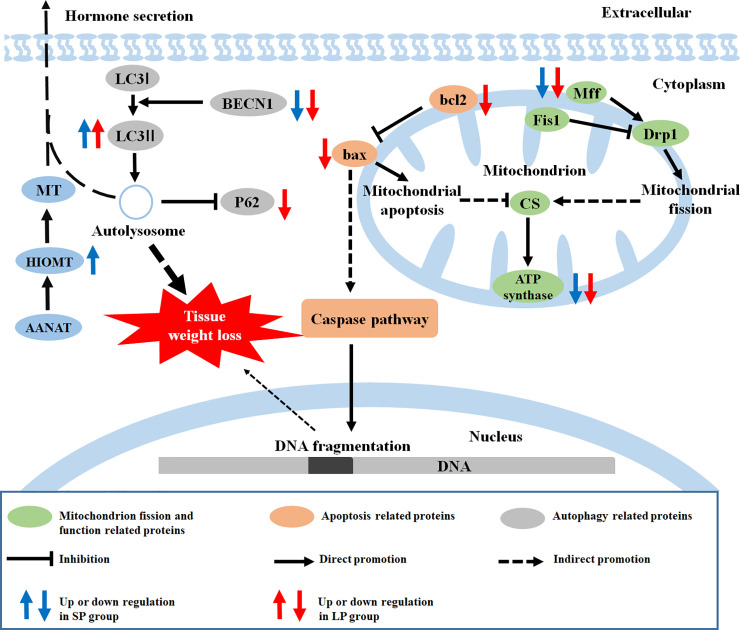
Graphical summary of study.Bax, bcl-2-associated X protein; bcl2, B cell lymphoma/leukemia-2; LC3, microtubule-associated protein 1 light chain; P62, sequestosome 1; BECN1, beclin1; MT, melatonin; HIOMT, hydroxyindole-O-methyltransferase; AANAT, arylalkylamine-N-acetyltransferase; Fis1, fission 1; Mff, mitochondrial fission factor; Drp1, dynamin-related protein 1; ATP synthase, adenosine triphosphate synthase; CS, citrate synthase; SP, short photoperiod; LP, long photoperiod.